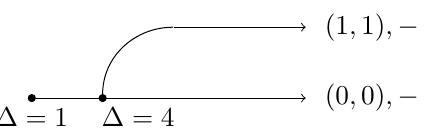
Figure 2 . Merging of scalar and vector lines due to a pole in vector blocks. Scaling dimensions indicate dimensions of the scalar